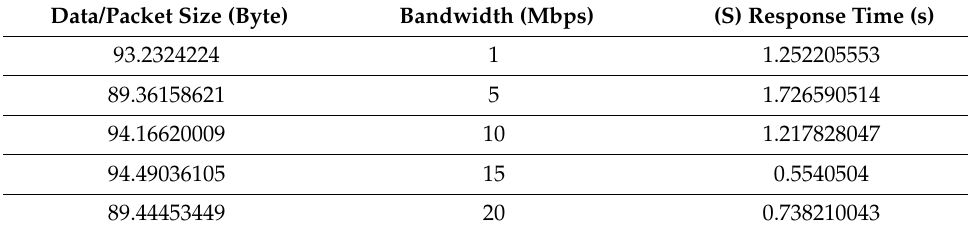
Table 5. HMS To IoT